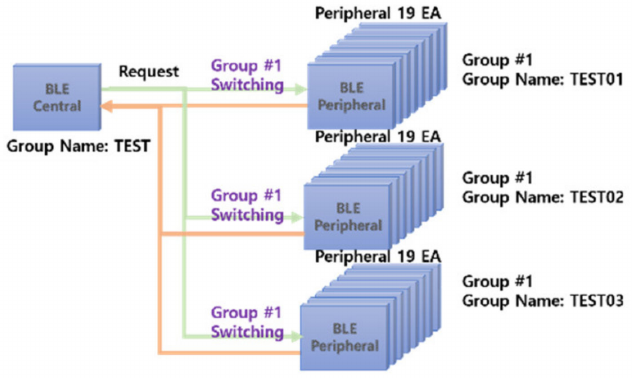
Figure 11. Experimental